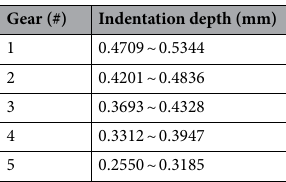
Table 1. Indentation depth range corresponding to 1# to 5# crimping gear for 20# contact.